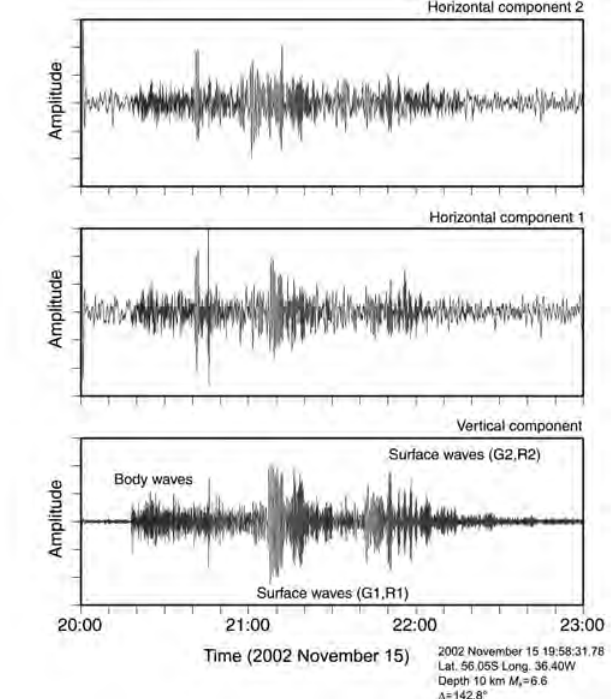
Fig. 10. Example of observed earthquake at the WP-1 Observatory. All the components are shown. The records were band-pass filtered at periods from 50 s to 5 s. The earthquake occurred in the region of South Sandwich Is- lands on November 15, 2002, and had a magnitude of 6.6. Epicenteral distance is about 143°. Minor- and ma- jor-arc Love and Rayleigh waves are clearly